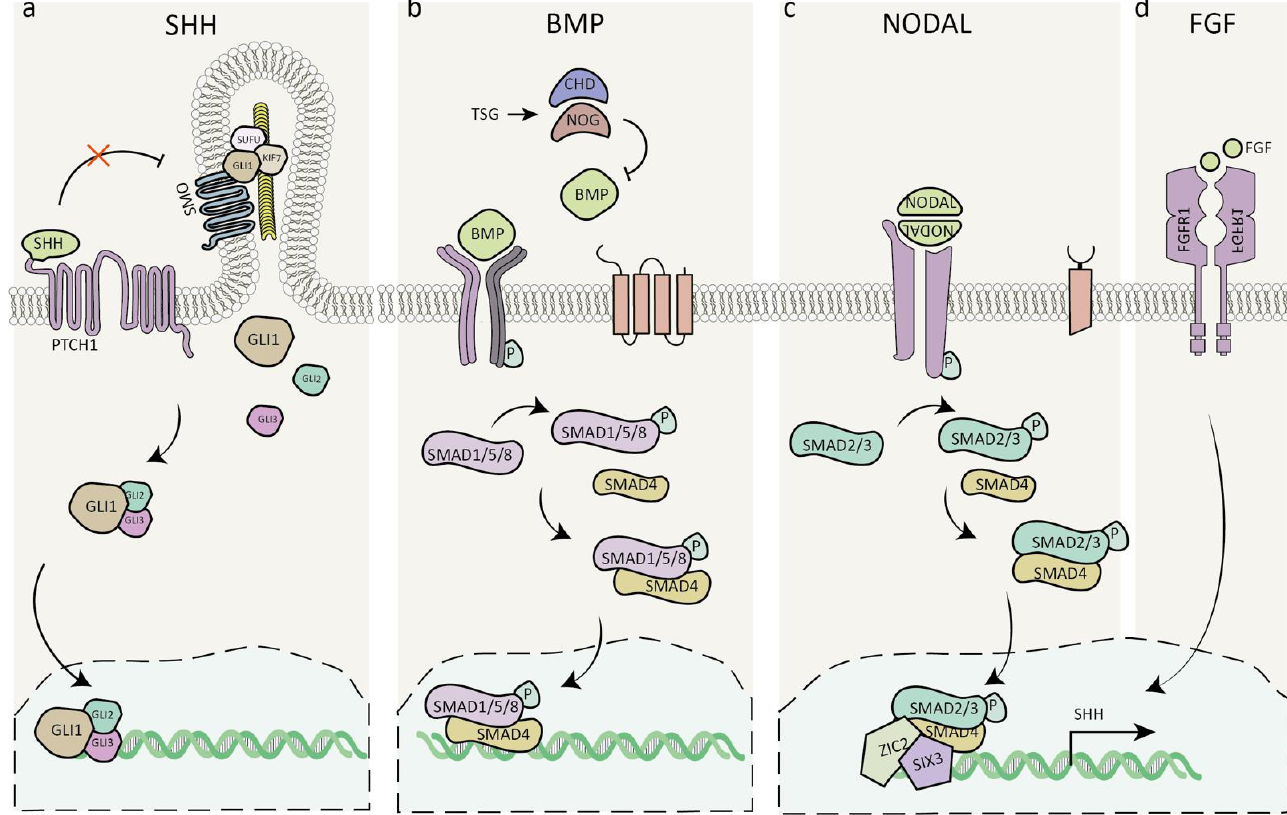
Figure 3. Signalling pathways involved in holoprosencephaly. ( a ) SHH signaling pathway. ( b ) BMP antagonists TSG/CHD/NOG suppress the activation of BMP downstream effectors. ( c ) Nodal signaling leads to the phosphorylation of smad2/3, which translocates to the nucleus, where it is thought to interact with ZIC2 and regulate SHH expression. ( d ) FGF signaling maintains SHH expression. Abbreviations: SHH, Sonic hedgehog; GLI1-3, glioma-associated oncogene homolog; PTCH1, Patched1; SMO, Smoothened; SUFU, Suppressor of fused homolog; KIF7, Kinesin family member 7; TSG, Twisted gastrulation; CHD, Chordin; NOG, Noggin; BMP, Bone morphogenic protein; P, Phosphate; SMAD, Mothers against decapentaplegic homolog; NODAL, Nodal growth differentiation factor; ZIC2, Zinc finger protein 2; SIX3, SIX homeobox 3; FGF/FGFR1, Fibroblast growth factor/receptor 1.